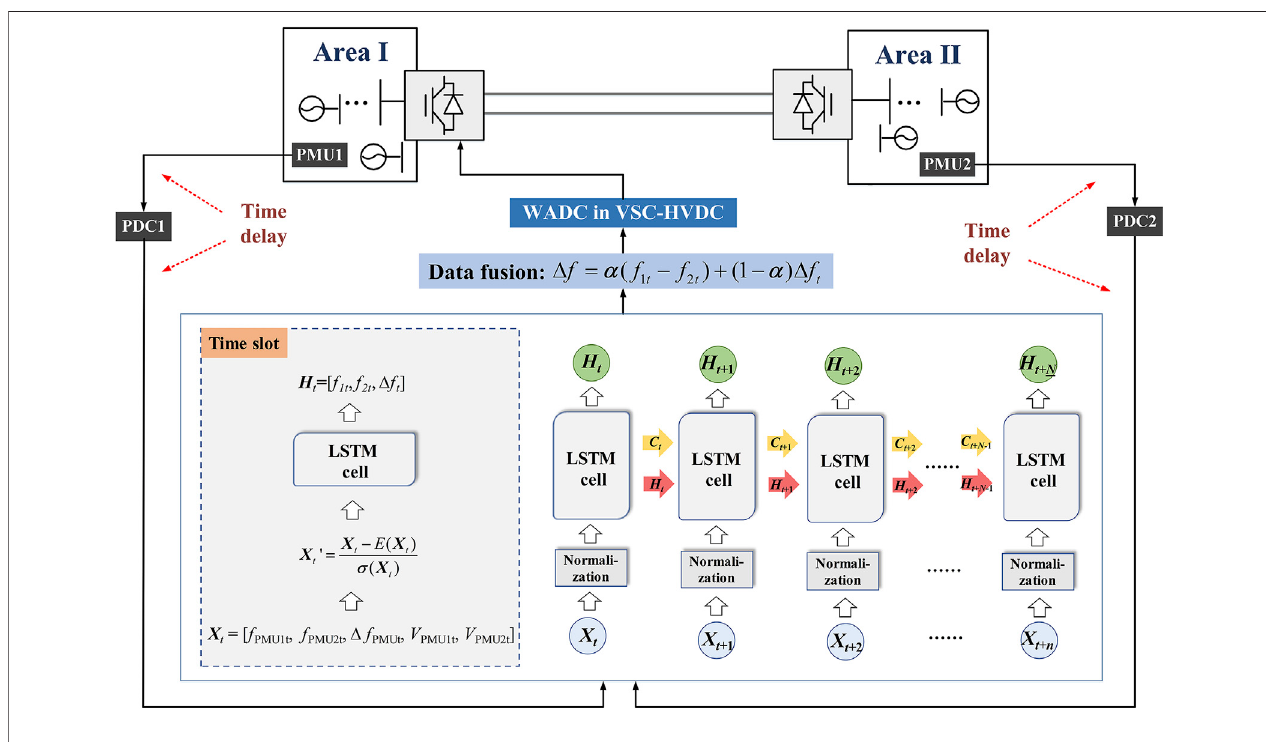
FIGURE 5 | Diagram of employing LSTM for time-delay